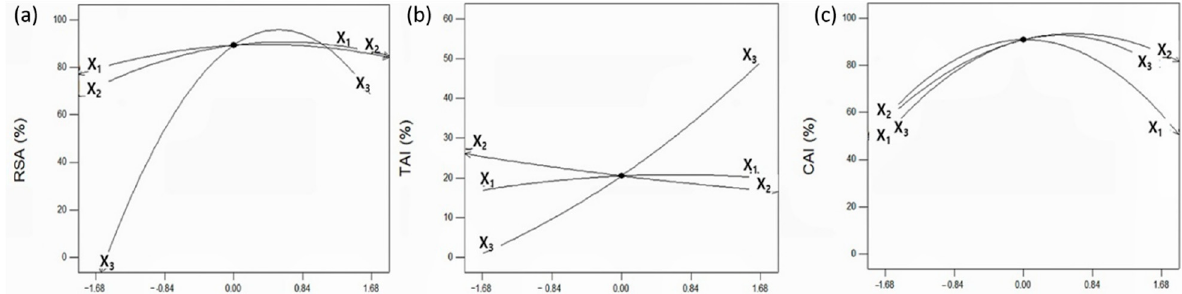
Figure 1. Perturbation plots for effects of extraction time (X 1 ), extraction temperature (X 2 ), and ethanol concentration (X 3 ) on the RSA, TAI, and CAI of peanut shell extract. Perturbation plots for RSA, TAI, and CAI of peanut shell extract shows all factors at a center point by changing one factor over its range while the other factors were fixed. Perturbation plots for RSA of peanut shell extract ( a ), Perturbation plots for TAI of peanut shell extract ( b ), Perturbation plots for CAI of peanut shell extract ( c ).